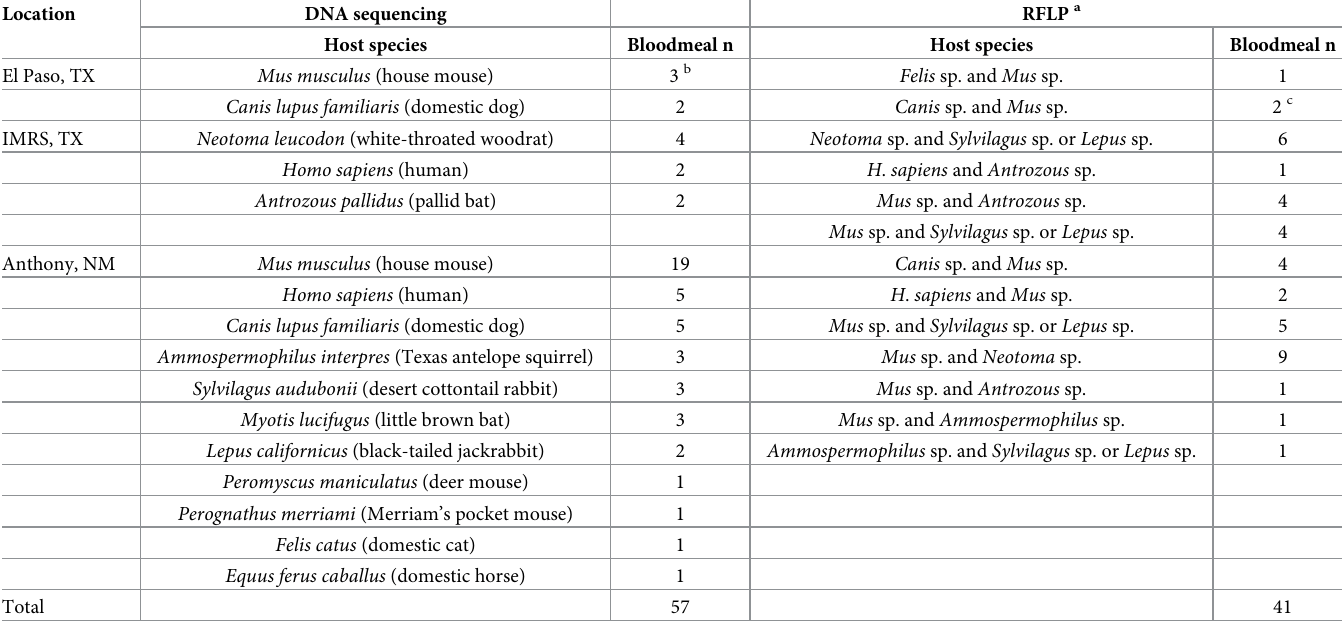
Table 2. Identification of mammalian host species that served as a bloodmeal source for T . cruzi- infected triatomines in El Paso and IMRS, TX, and Anthony, NM, identified by DNA sequencing and RFLP analysis.